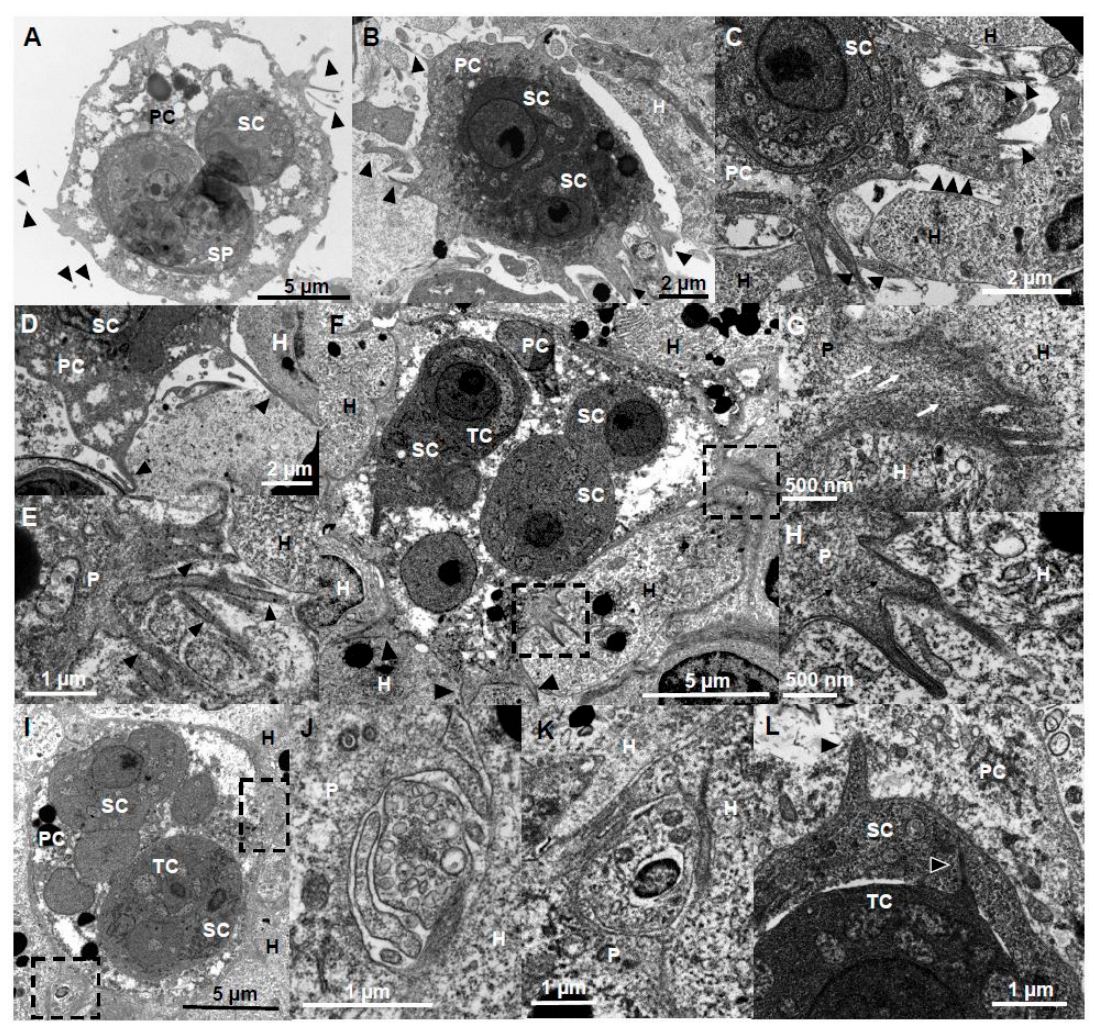
Figure 4. Ultrastructure (TEM) of cell protrusions of adhesive stages of Ceratonova shasta genotype IIR in rainbow trout. ( A ) Sporogonic stage, containing a forming spore and a secondary cell, showing small thin filopodia protruding from the primary cell. ( B ) Parasite stage containing two secondary cells with abundant pseudopodia being projected into the ECM. ( C ) Plasmodia showing a large sheet-like lamellipodia and filopodia protruding into a degraded ECM. ( D ) Parasite stage protruding two long and thin filopodia between host cells. ( E ) Group of filopodia being projected from a parasite. ( F ) Large parasite stage containing two primary nuclei, three secondary cells, one of them with a tertiary cell, with filopodia and lamellipodia deeply embedded (anchored) in the surrounding host cells (boxes). ( G , H ) Detail of the the filopodia-lamellipodia in F, showing a mesh of actin filaments supporting the protrusion. ( I ) Parasite stage presumably feeding by endocytosis, using cell protrusions to capture small portions of host cells. ( J , K ) Endocytosis processes in ( I ), small parasite protrusions engulfing host cell fragments. ( L ) Detail of a parasite stage showing small filopodia being protruded by the secondary cell into the primary cell, and by the tertiary cell into the secondary cell. A , B , D , Intestine; C , E , I – L , caeca; F – H testes. Head arrows, filopodia and lamellipodia; black arrows, actin filaments; SP, spore, PC, primary cell, SC, secondary cell, TC, tertiary cell, H, host cell, P,